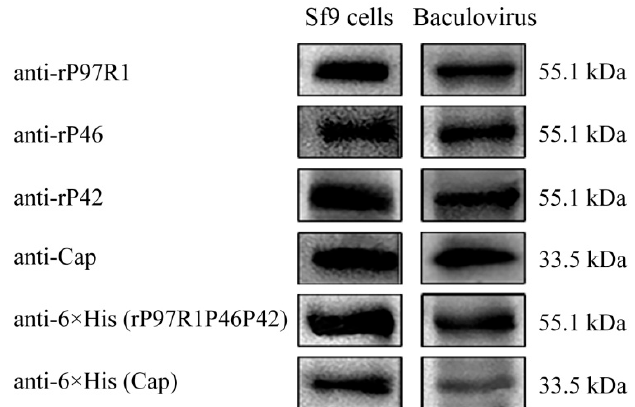
Figure 2. Detection of P97R1P46P42 and Cap expression in rvAc-P97R1P46P42-Cap-infected Sf9 cells and concentrated baculovirus rvAc-P97R1P46P42-Cap.